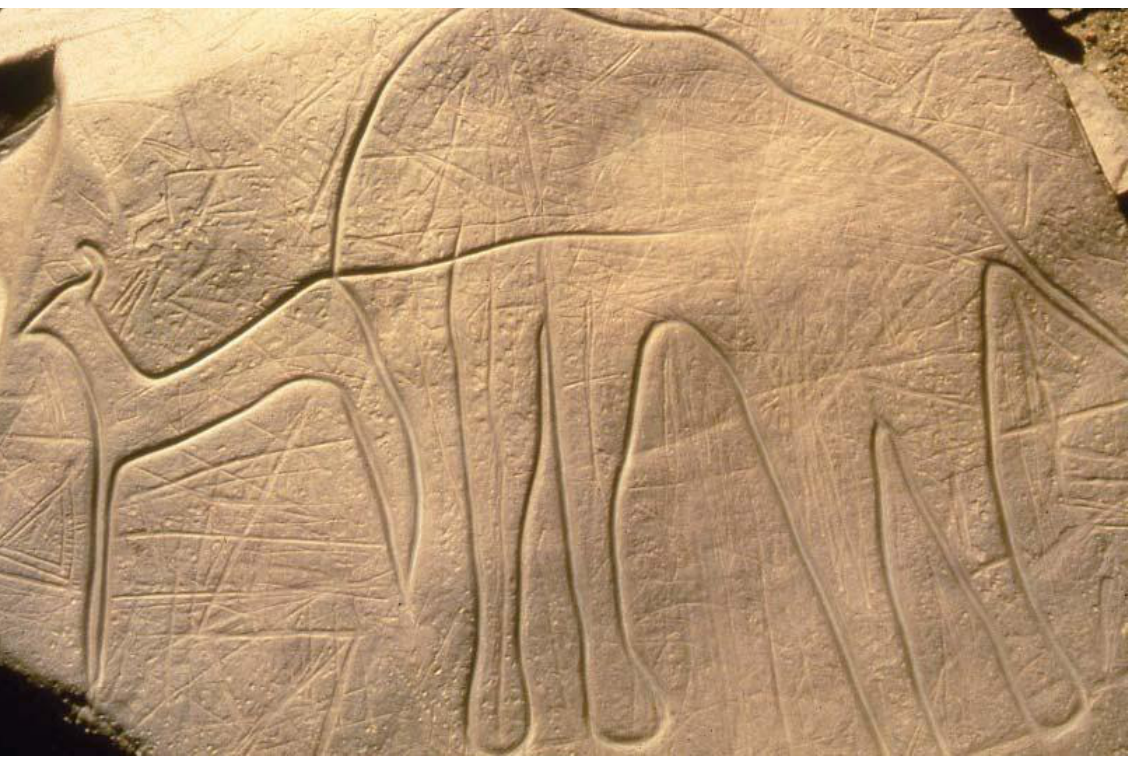
Figure 2. Tazina style animals from Ait Ouazig, River Draa valley, south-east of